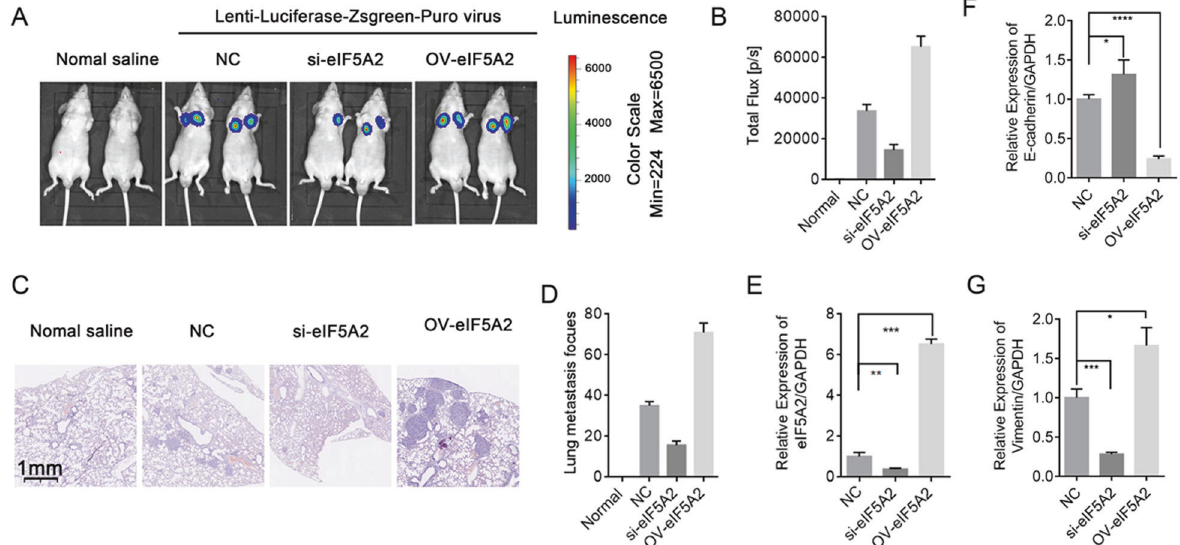
Fig. 6 EIF5A2 regulates metastasis in vivo. A , B Luciferase expression in intrahepatic tumors in different treatment groups (normal saline, NC, eIF5A2 mimics, eIF5A2 inhibitor). C , D Images showing HE staining of lung tissues. E – G qRT-PCR con fi rmed the expression of eIF5A2, E- cadherin, and Vimentin expression after transfection with eIF5A2 siRNA or